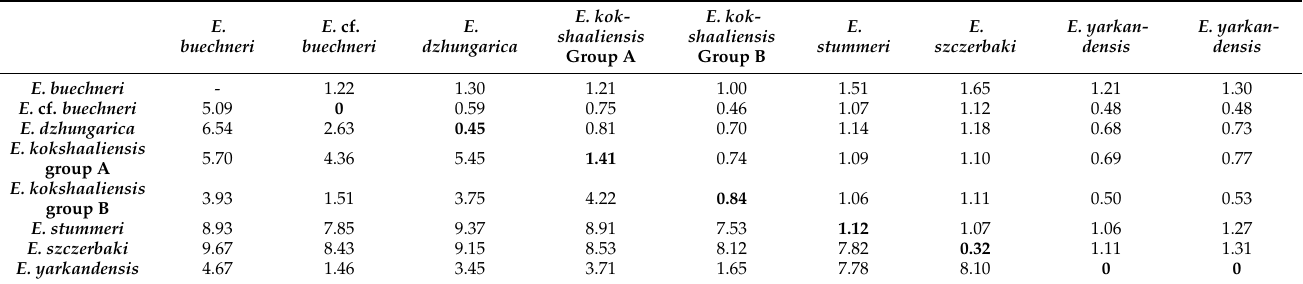
Table 3. Uncorrected p -distances (%) for sequences of mtDNA COI gene for groups (below the diagonal). Values on the diagonal correspond to average uncorrected ingroup p -distances. Standard- error estimates are shown above the